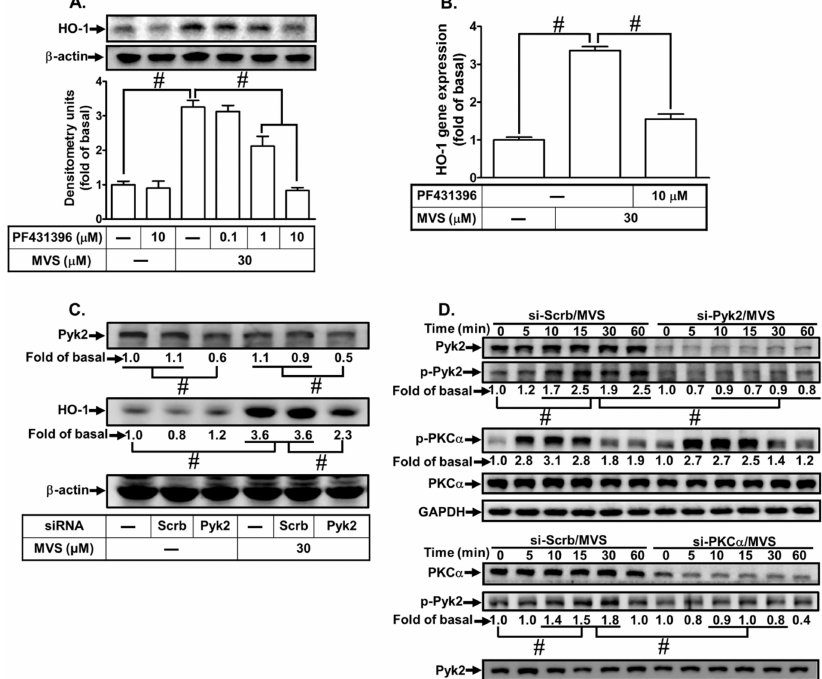
Figure 3. Phosphorylation of Pyk2 is involved in the MVS-induced HO-1 expression. ( A ) HPAEpiCs were pretreated with various concentrations of PF431396 for 1 h, and then incubated with vehicle or MVS (30 µ M) for 24 h. The levels of HO-1 and β -actin protein expression were determined by Western blot. ( B ) The cells were pretreated with PF431396 (10 µ M) for 1 h and then incubated with vehicle or MVS (30 µ M) for 8 h. The levels of HO-1 mRNA were analyzed by real-time qPCR. ( C ) HPAEpiCs were transfected with scrambled (Scrb) or Pyk2 siRNA, and then incubated with MVS for 24 h. The levels of Pyk2, HO-1, and β -actin protein expression were determined by Western blot. ( D ) HPAEpiCs were transfected with PKC α or Pyk2 siRNA and then treated with MVS for the indicated time intervals. The levels of phospho-PKC α , PKC α , phospho-Pyk2, Pyk2, and GAPDH were determined by Western blot using respective antibodies. Data are expressed as mean ± SEM of five independent experiments ( n = 5). # p < 0.01, as compared with the cells exposed to the indicated